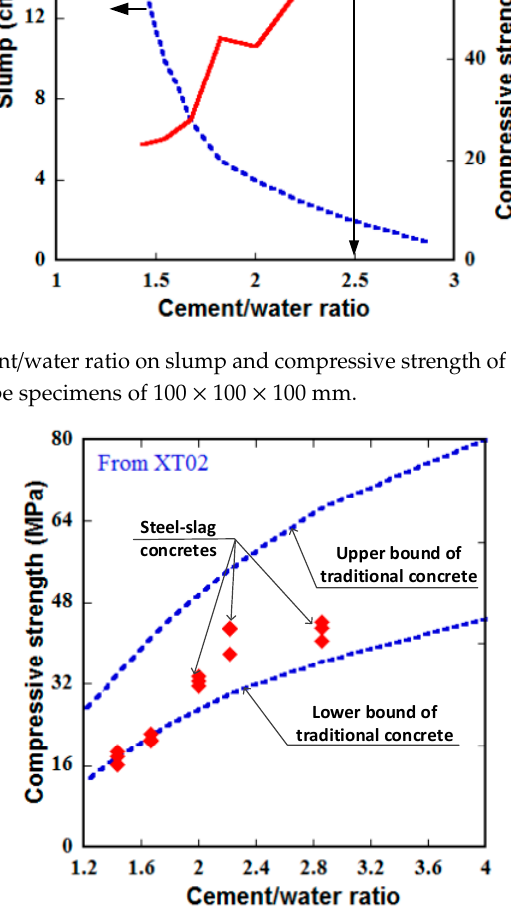
Figure 16. Relationship between 28-day compressive strength and cement/water ratio of the steel-slag concretes in comparison with traditional concrete using cylinder specimens of 150 × 300 mm.